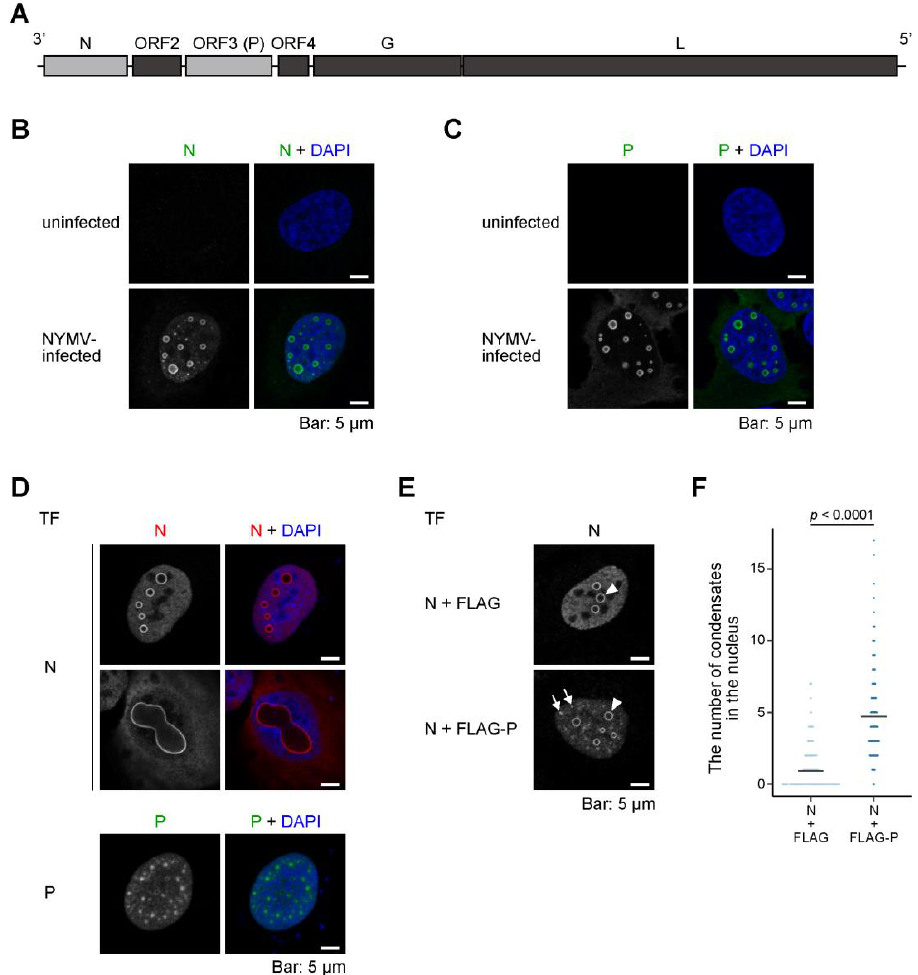
Figure 1. The formation of IBs-like structures by NMYV N and P. ( A ) A schematic diagram of the genome structure of NYMV. The gene regions of N and P are highlighted in grey. ( B , C ) The localizations of N ( B ) and P ( C ) in NYMV-infected U-2 OS cells revealed by confocal immunofluorescence microscopy using specific antibodies. ( D ) The localization of N or P that was exogenously expressed by transfection (TF) in uninfected U-2 OS cells revealed by confocal immunofluorescence microscopy using anti-N or anti-P antibodies, respectively. ( E ) The localizations of N in uninfected U-2 OS cells that were transfected with N and FLAG-tag ( upper ) or N and FLAG-tagged P ( lower ). Arrowheads and arrows indicate condensates and puncta, respectively. ( F ) The number of condensates in the nucleus in ( E ). n > 300 from three samples. Statistical significance was assessed by using a two- tailed Welch’s t -test. The confocal microscopic images presented in ( B – E ) were the images of single focal planes.